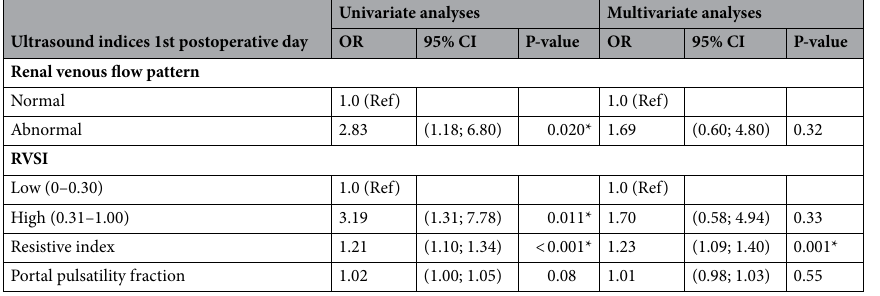
Table 2. Univariate and multivariate logistic regression models for the odds ratio (OR) of developing AKI after cardiac surgery according to studied variables on the first postoperative day. Multivariate logistic regression adjusted for cardiopulmonary bypass (CPB) time and EuroSCORE II. OR, 95% CI (confidence interval) and P-value for developing any degree of AKI after cardiac surgery with no AKI as reference group. All values except EuroSCORE II refer to the first postoperative day. Renal venous flow pattern and renal venous stasis index (RVSI) are treated as categorical variables. Other variables are treated as continuous variables. Higher OR depicts higher risk of AKI. * Indicates statistically significant difference (P < 0.05). AKI acute kidney injury, CPB cardiopulmonary bypass.